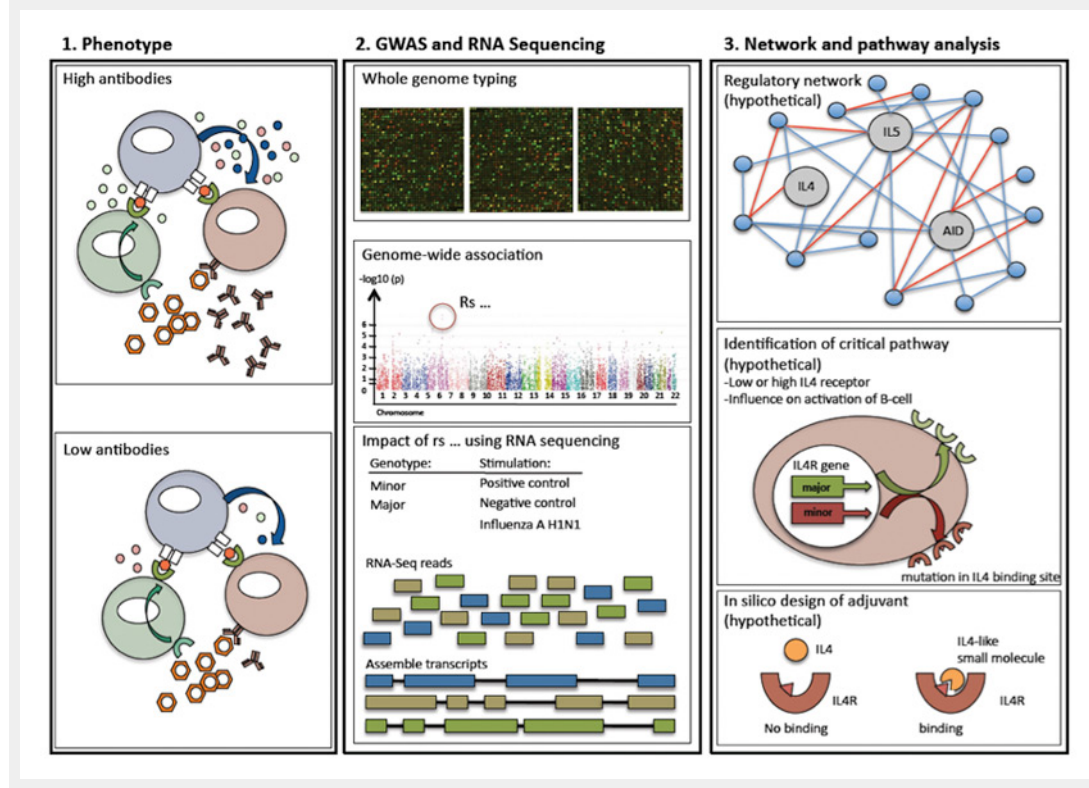
Possible work-flow to develop novel adjuvants. The following example is only used as an illustration and not based on “real” data – it should highlight critical steps, which could be used for different vaccines and pathways. First step: observation of distinguished phenotypes, such as antibody production different due to defective cytokine production. Second step: description of respective phenotype – identification of involved genes using a genome-wide association study. Next, RNA sequencing could be used to describe the pathophysiological impacts of the newly discovered SNP. Third step: generation of a genetic network to identify critical interaction points (so called gene hubs). In our “imaginary example” an important cytokine receptor would be affected – the interleukin 4 receptor. In-silico design of small molecules, which can modulate or compensate for the polymorphisms in the signalling cascade. In this example IL4 cannot bind sufficiently owing to a mutation within the IL4-receptor. A small molecule could be specifically designed to overcome this.